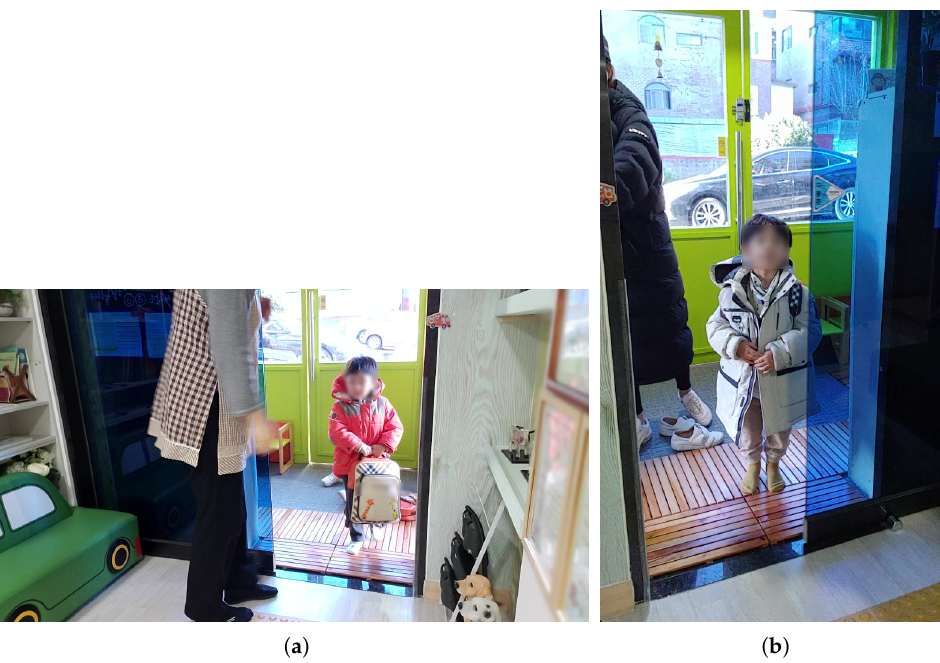
Figure 11. Actual captured images in Figure 10: ( a ) tablet PC; ( b ) smartphone. Third, in this study, the tablet PC was installed on the left, and the smartphone was installed on the right, as shown in Figure 12. The test video was filmed for about two and a half hours, from 8:00 to 10:30 a.m., when children come to the daycare center. The camera installation results are shown in Figure 13. We assumed that by moving the camera to the right, it would be possible to shoot a part that could not already be seen based on where the existing tablet PC was installed. However, in this location, the children were often surrounded by teachers, and there were stairs next to it, which made it difficult for the children to move.